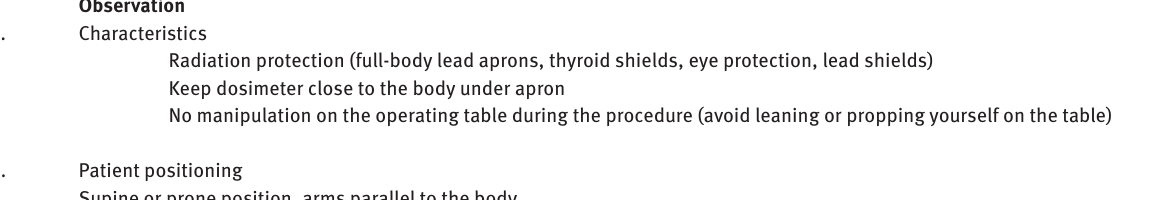
Table 2: Intraoperative SOP during neurointervention I.